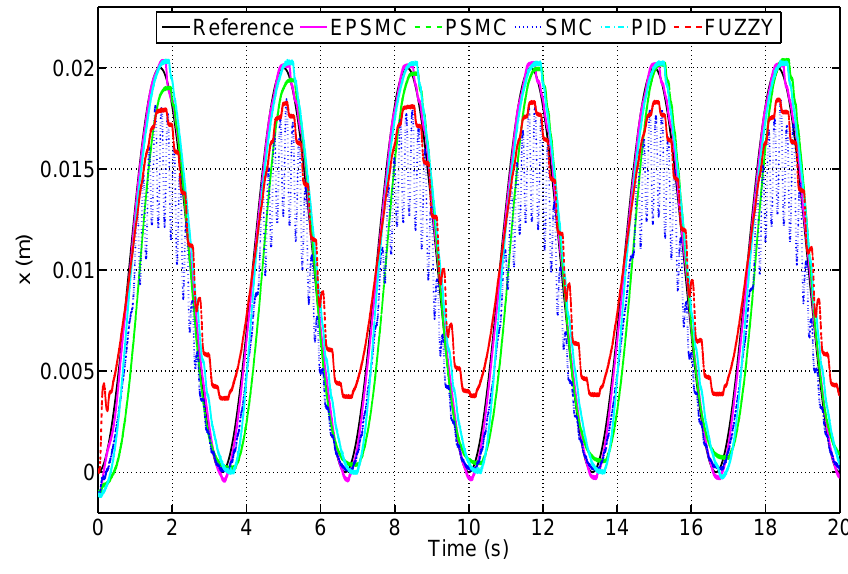
Figure 4. The tracking performance of the PMA.